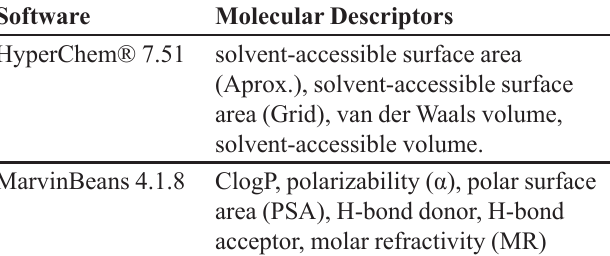
TABLE II - Molecular descriptors calculated using